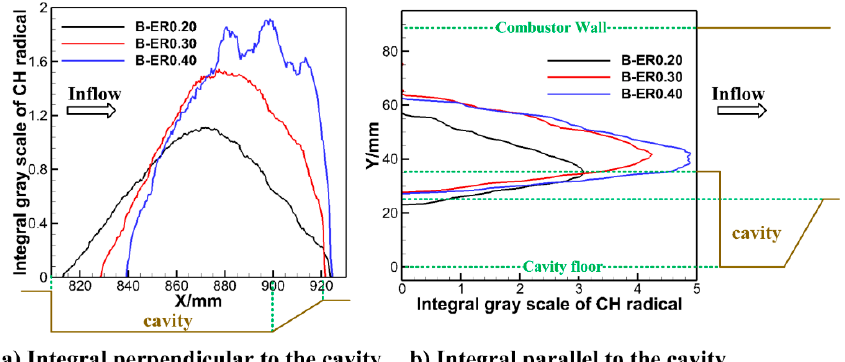
Figure 10. Gray scale integration distributions of the time-averaged CH* spontaneous emission images in the injection Scheme B cases.